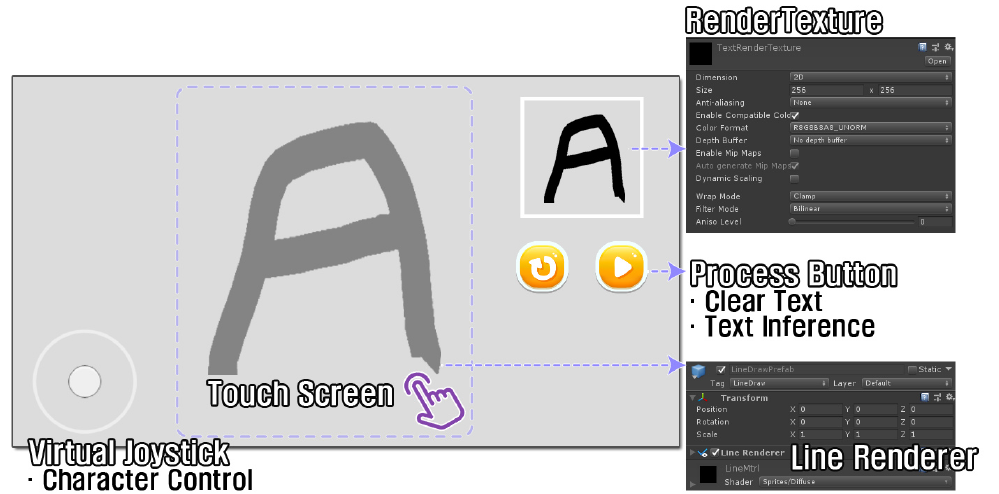
Figure 2. Text interface composition and processing